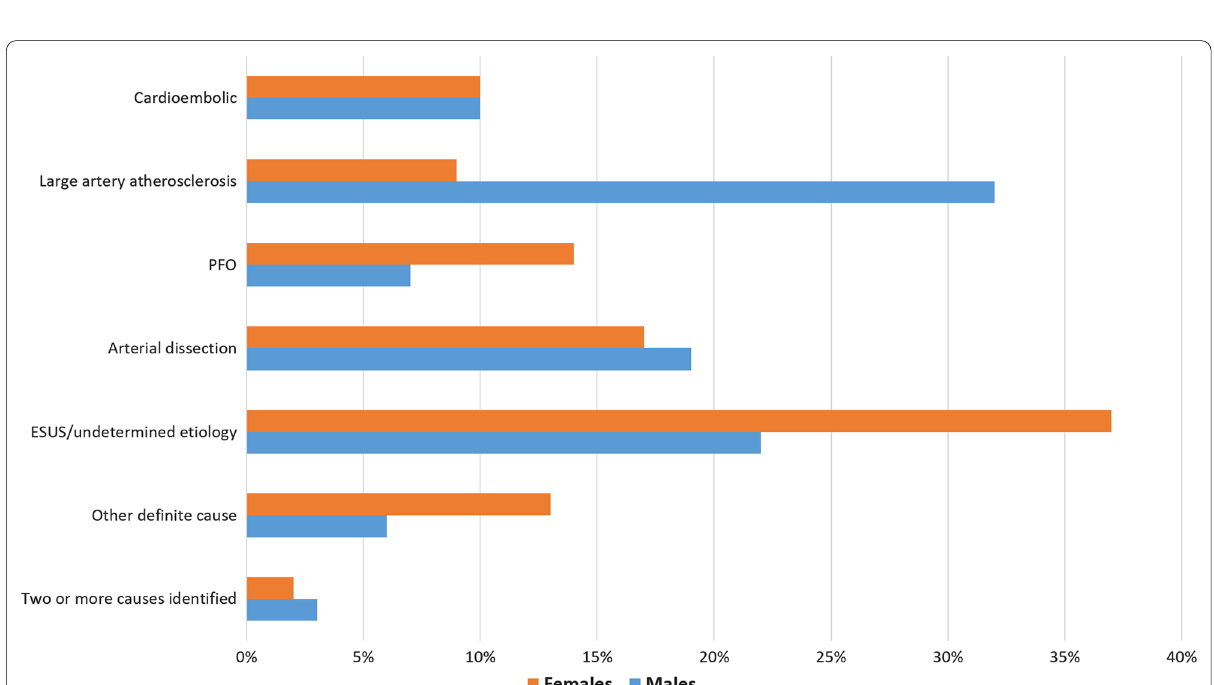
Fig. 1 Causes of ischemic stroke in young female (orange) and male (blue) patients undergoing mechanical